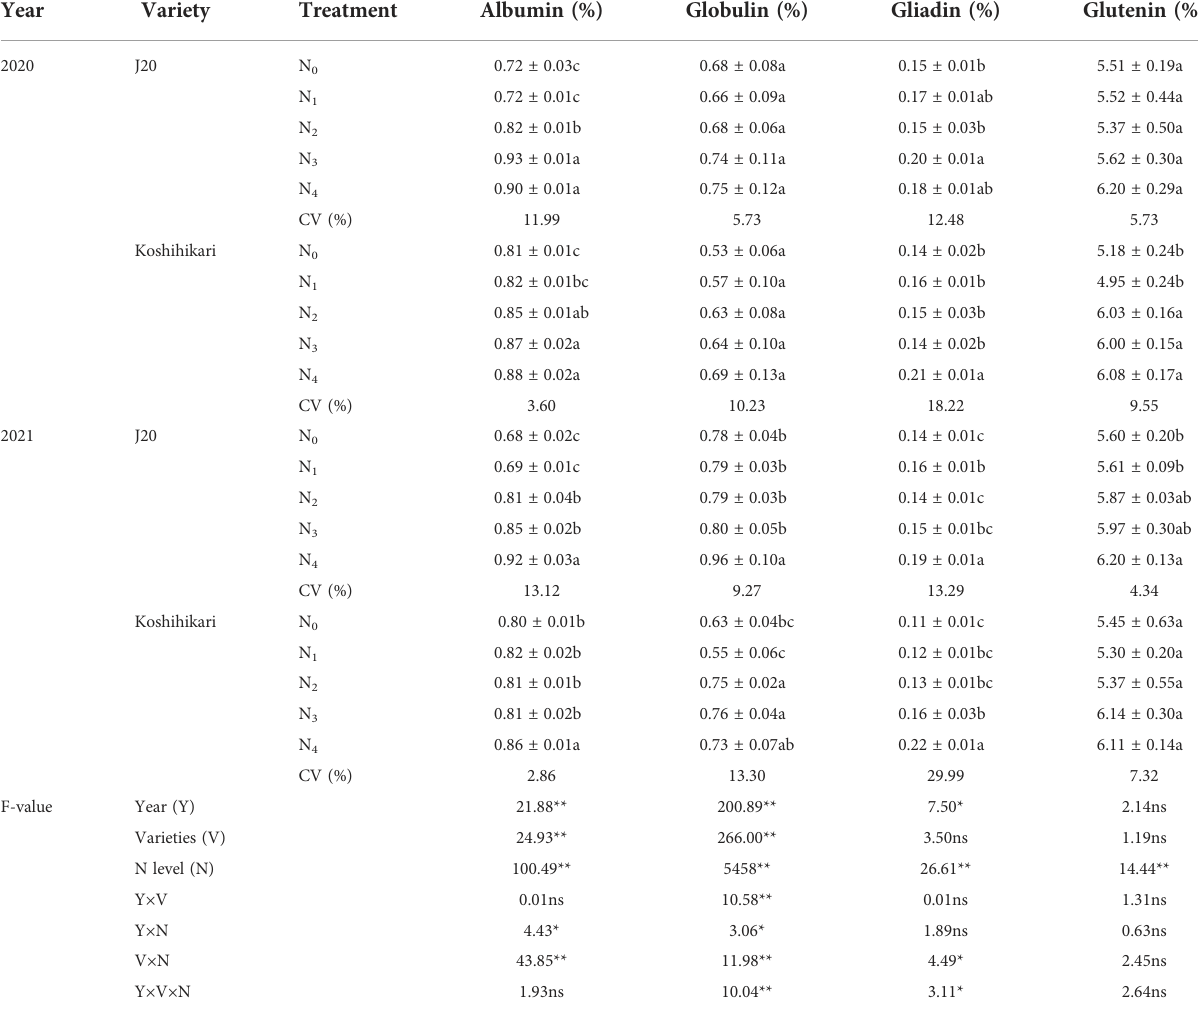
TABLE 6 Effect of N application rate on protein component of brown rice fl our. Year